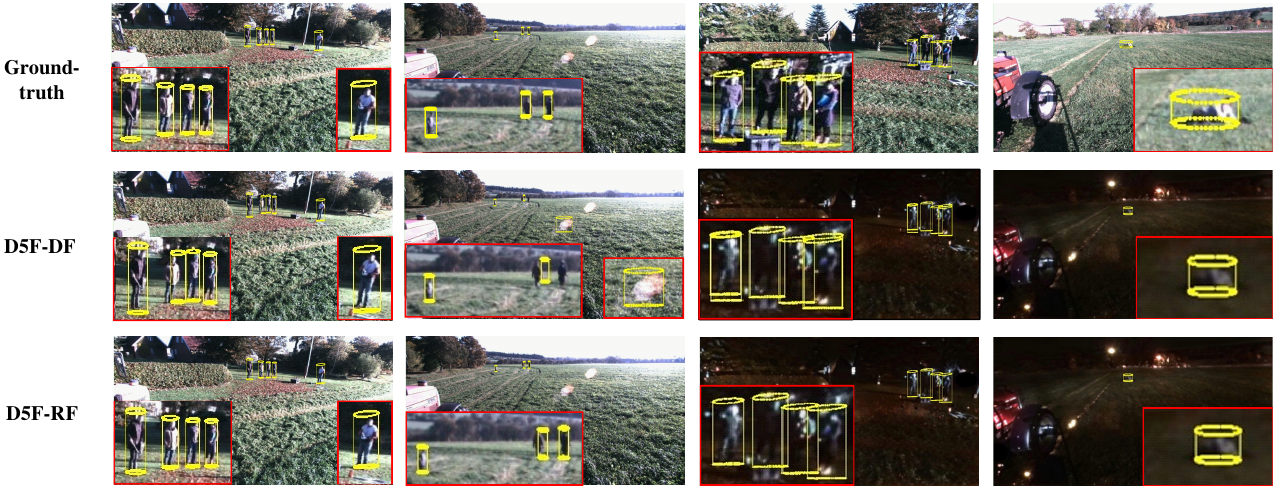
Figure 12. Detection results of D5F-DF and D5F-RF on test images. Small objects are displayed in a zoomed red window.